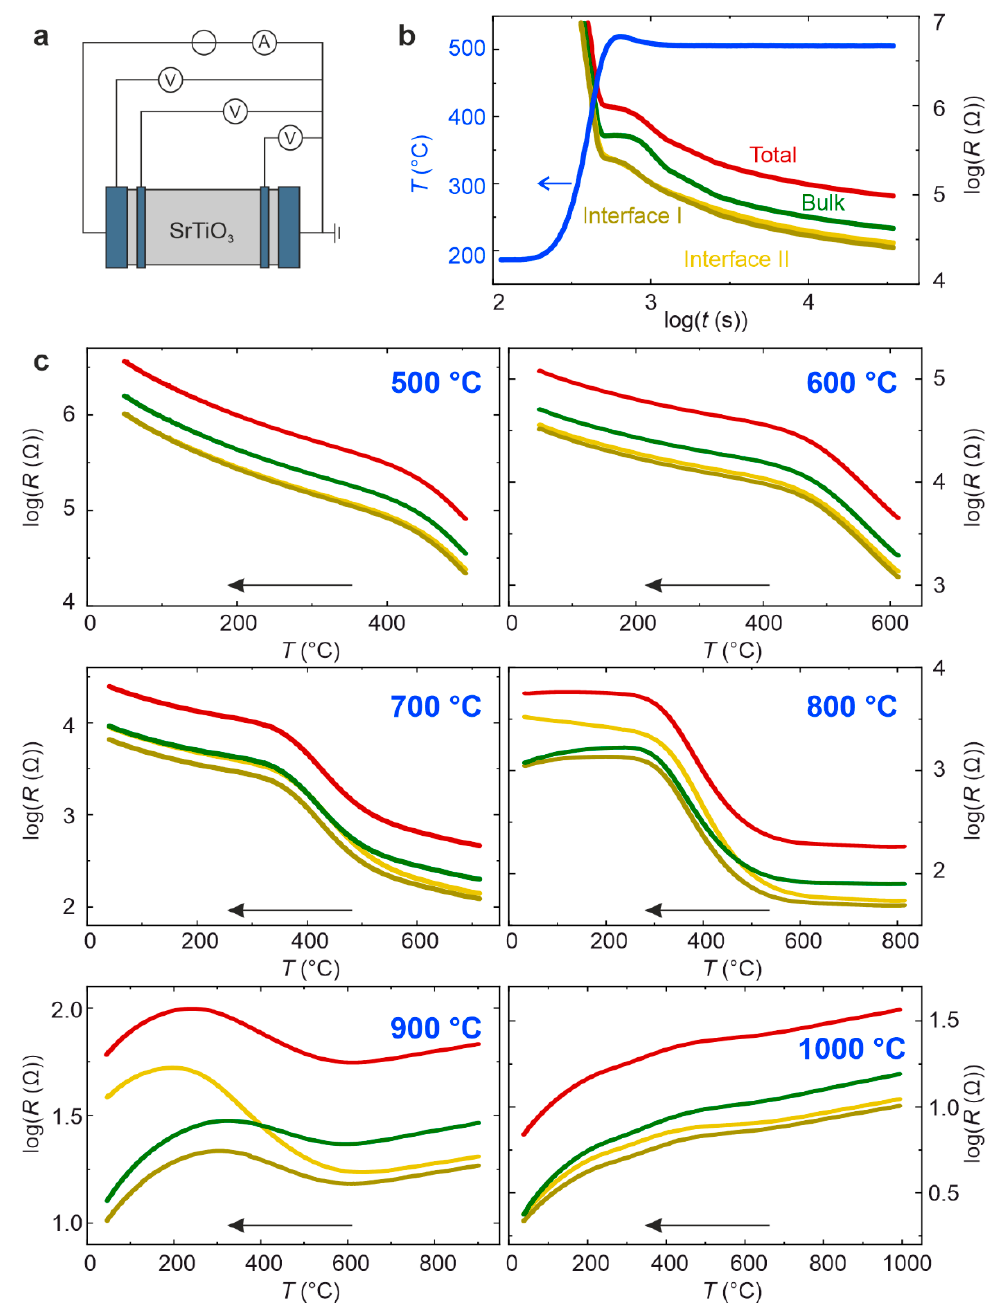
Figure 1. Four probe resistance measurements of the SrTiO 3 single crystal: ( a ) schematic setup; ( b ) total and partial resistances of the sample during the first heating to 500 °C; ( c ) cooling curves of the resistances after thermal reduction at increasing maximum temperatures.